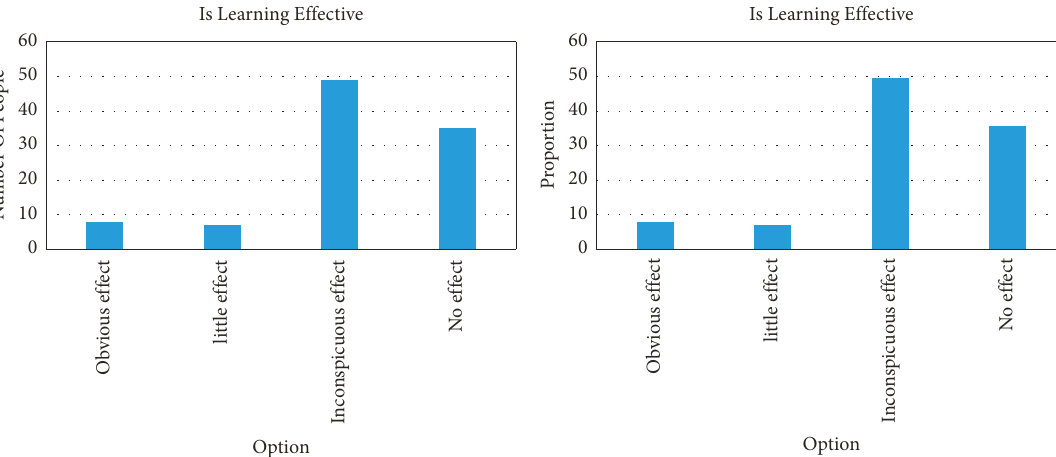
Figure 7: Whether learning mental health education courses is effective.